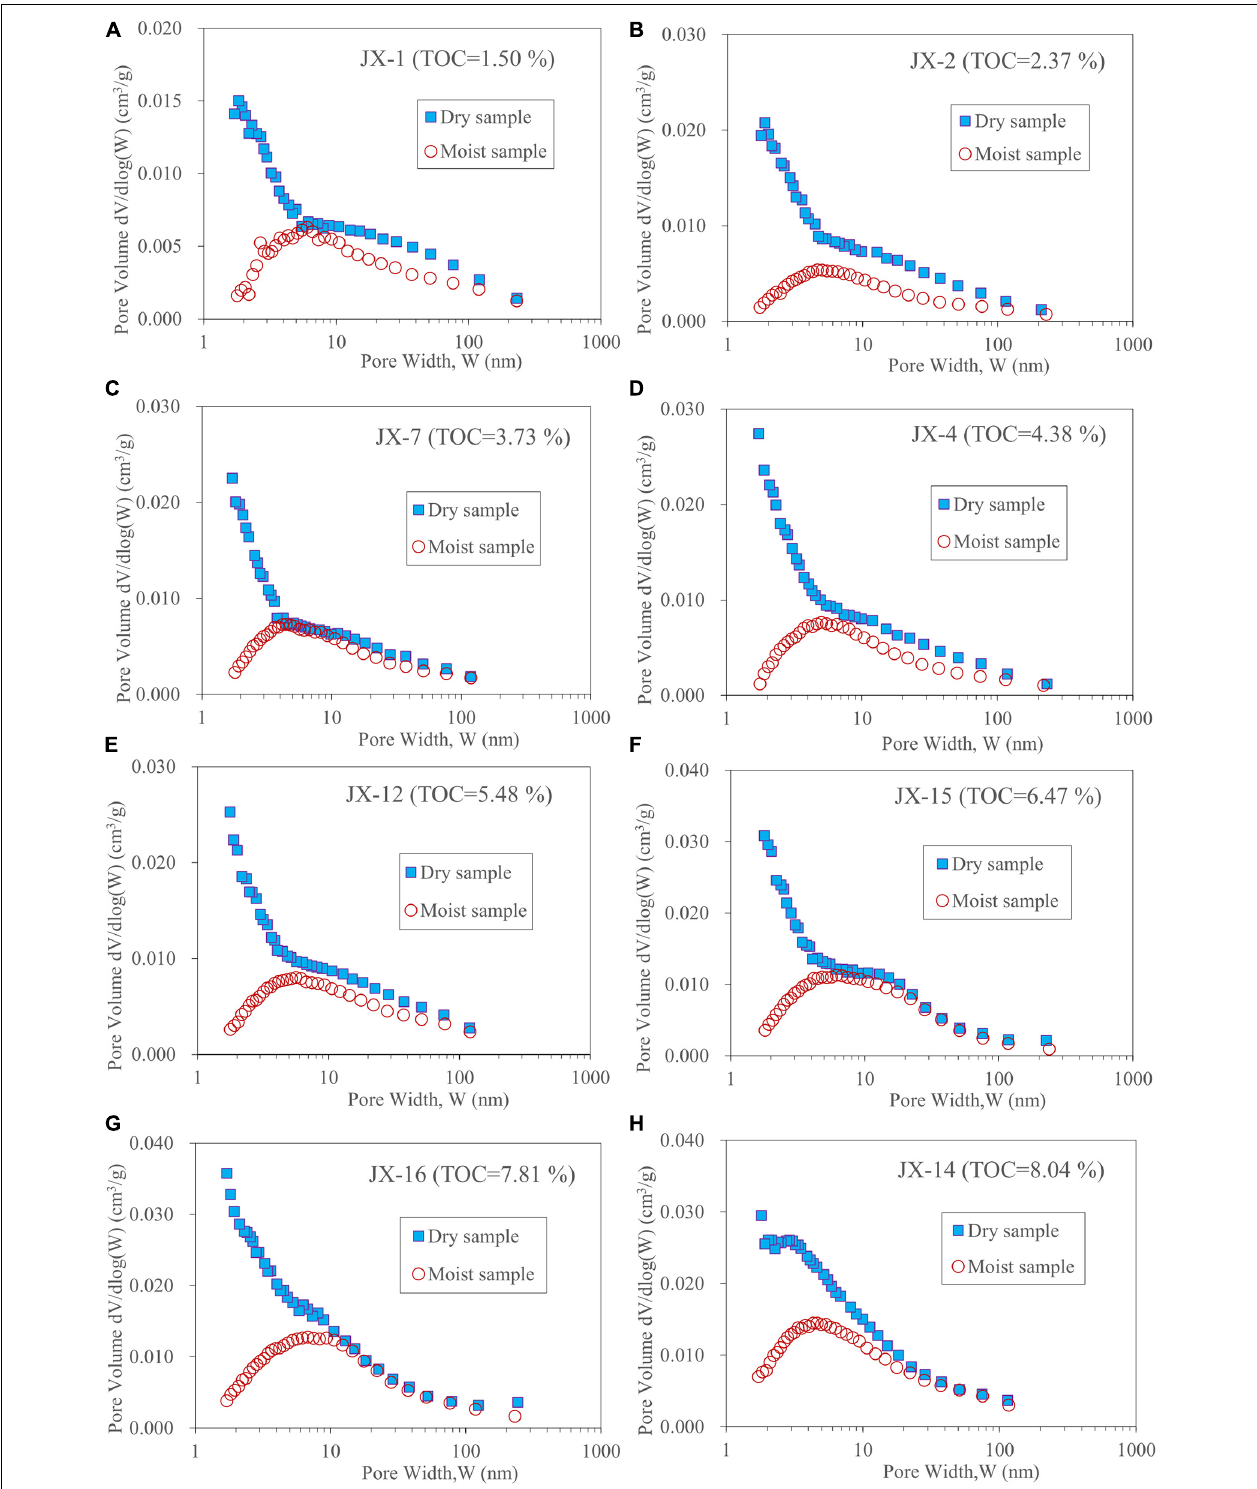
FIGURE 3 | Plots showing the BJH pore-size distributions of the selected 8 pairs (dry and moist) samples based on the N 2 adsorption analysis (A–H) . The dry and moist samples have different PSD shapes. Note that water in sample JX-2 (B) occupies a broader pore size range compared with other samples shown in A,C–H , up to 110 nm, may be due to, in part, its greater pore water content ( Table 2 ).